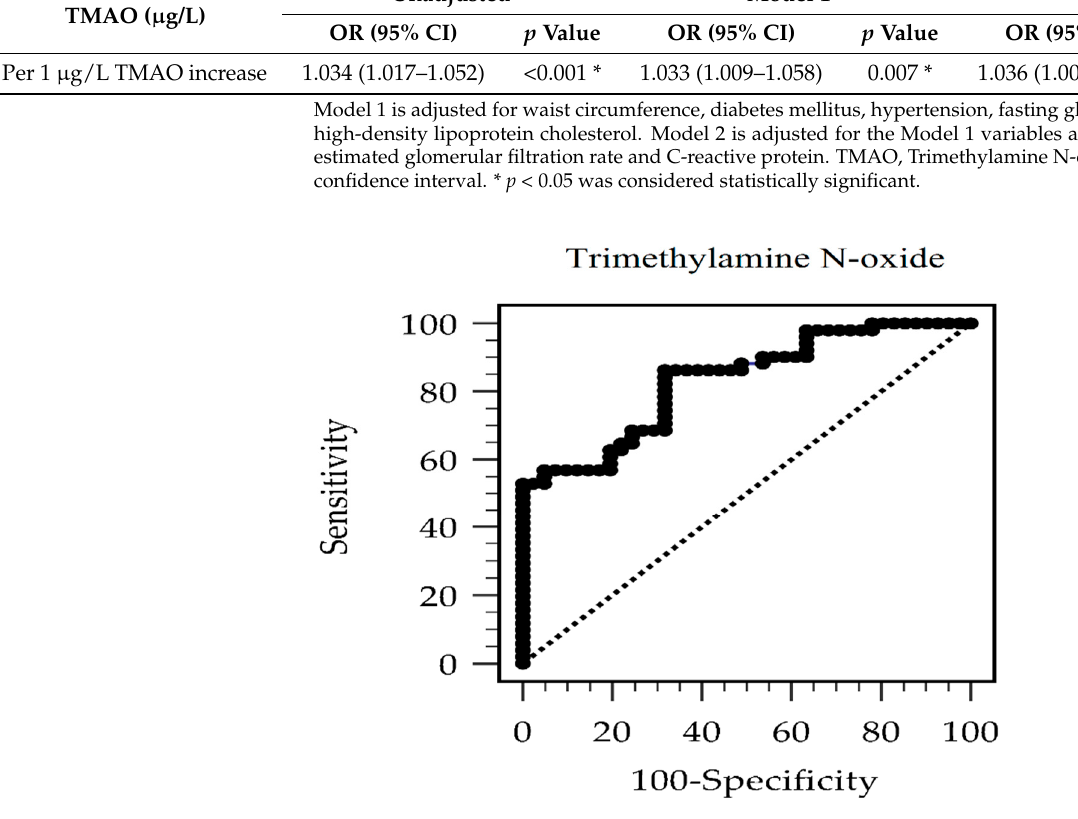
Figure 2. ROC curve for metabolic syndrome prediction by trimethylamine N-oxide level.